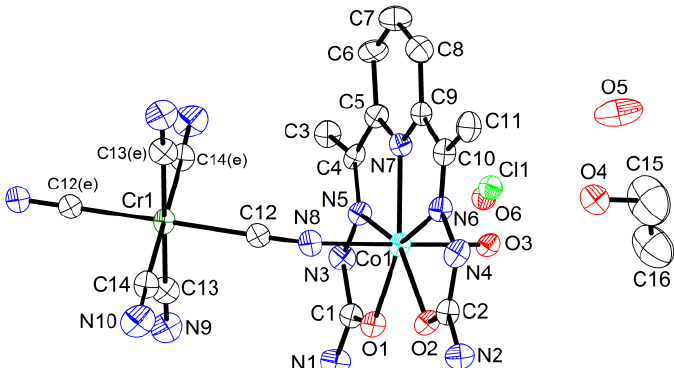
Figure 6. Asymmetric unit in 4 with atom numbering scheme (ORTEP drawing with 50% probability ellipsoids). Colored atoms: Cl (light green), Co (cyan), Cr (green), N (blue), O (red). Symmetry code: (e) (1 − x , − y , − z ).